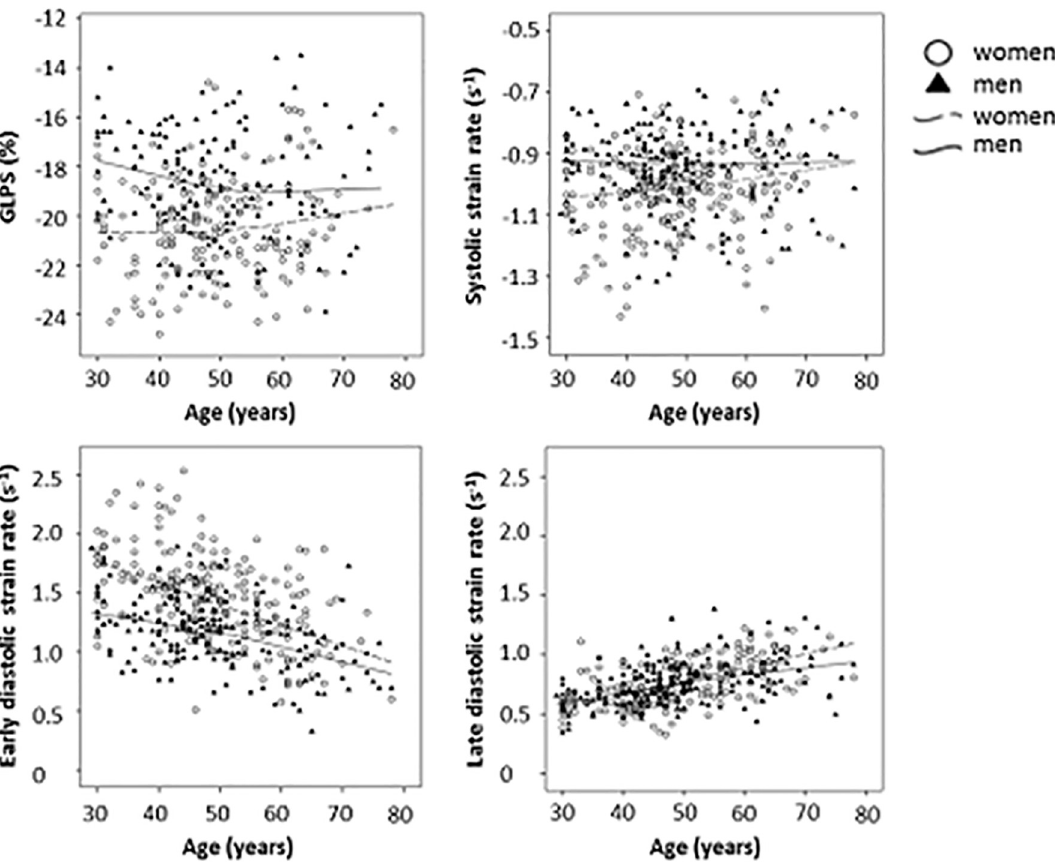
Fig 2. Combined averaged a) global longitudinal peak systolic strain (GL-PSS, n = 323), b) systolic strain rate (GL-SSR, n = 410), c) early diastolic strain rate (GL-EDSR, n = 410), and d) late diastolic strain rate (GL-LDSR, n = 407) according to age and sex in individuals in sinus rhythm free from cardiovascular risk factors and cardiovascular disease (mean age 49 ± 11 years, 55%